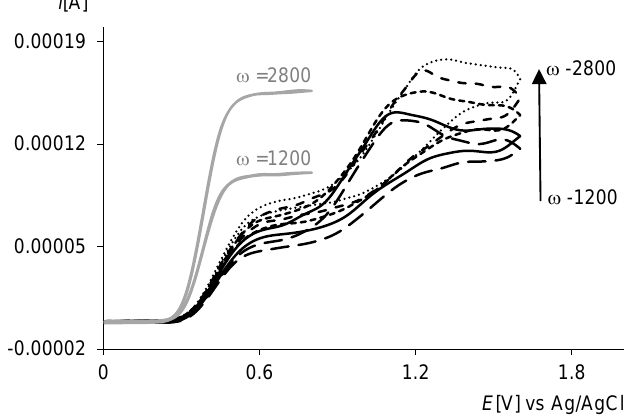
Figure 9. Cyclic voltammograms, 2nd scan, v = 0.05 V · s − 1 , vs. Ag/AgCl, ω : 1200, 1600, 2000, 2400, 2800 rad 1/2 · s − 1/2 ; at rotating Pt disc electrode in ferrocene (10 − 3 mol · dm − 3 )//TBAH/CH 2 Cl 2 —grey lines; at rotating Pt poly [Ni(salcn)] disc electrode ( Γ = 5.39 × 10 − 9 mol · cm − 2 ) in ferroceneTBAH (0.1 mol · dm − 3 )/CH 2 Cl 2 —black